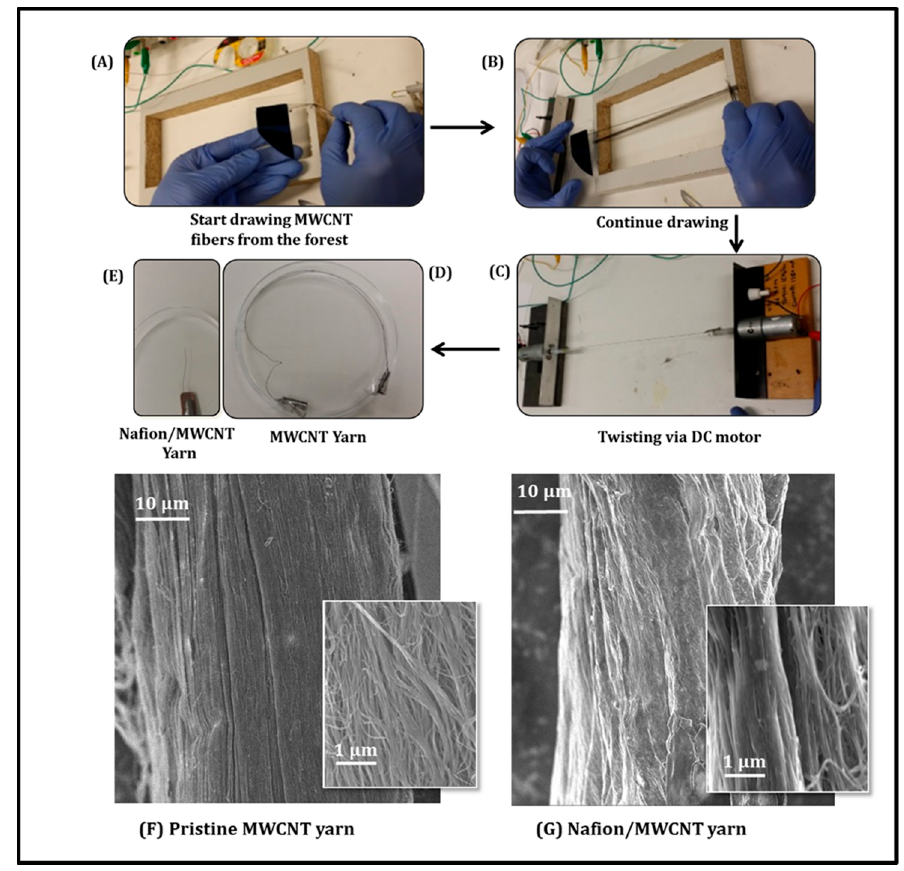
Figure 1. Schematic illustration of the preparation method of Nafion/MWNT Yarn ( A – E ); SEM images of MWNT yarn without/ with Nafion coating ( F , G ).